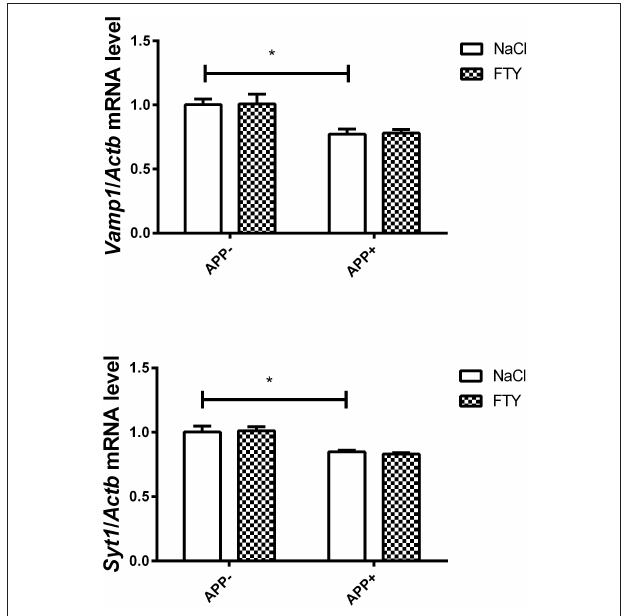
FIGURE 2 | Levels of mRNAs coding for synaptic proteins VAMP1 and SYT1 in the 3-month-old mouse hippocampus: effect of A β PP and FTY720. Levels of mRNAs measured in the hippocampus of 3-month-old (adult) mice as described in Materials and methods. mRNA levels in A β PP-expressing mice were compared with control animals that did not inherit the transgene. Effect of FTY720 administration was assessed against vehicle-treated animals in each group. Vamp1 , vesicle-associated membrane protein 1; Syt1 , synaptotagmin 1; APP − , animals without V717I A β PP transgene; APP + , mice expressing V717I A β PP transgene. * p < 0.05 vs. corresponding controls, two-way ANOVA followed by Tukey’s post-hoc test (horizontal bars: effect of A β PP). n = 3–4, measured in triplicate ±